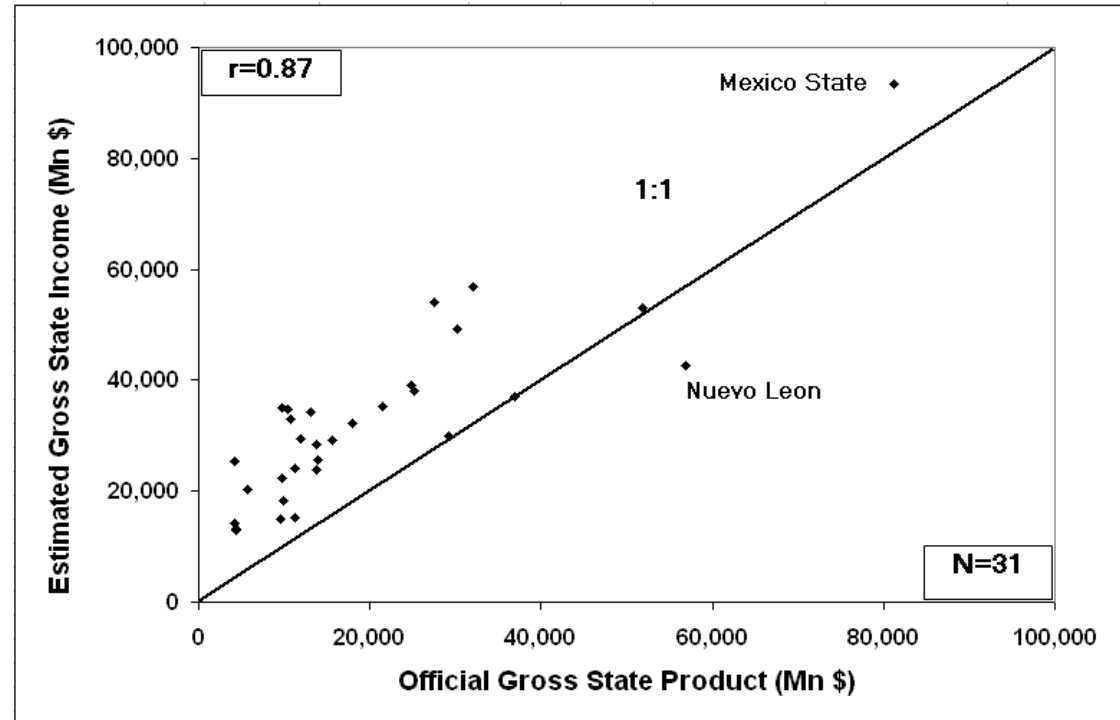
Figure 11. Official GSP Distrito Federal